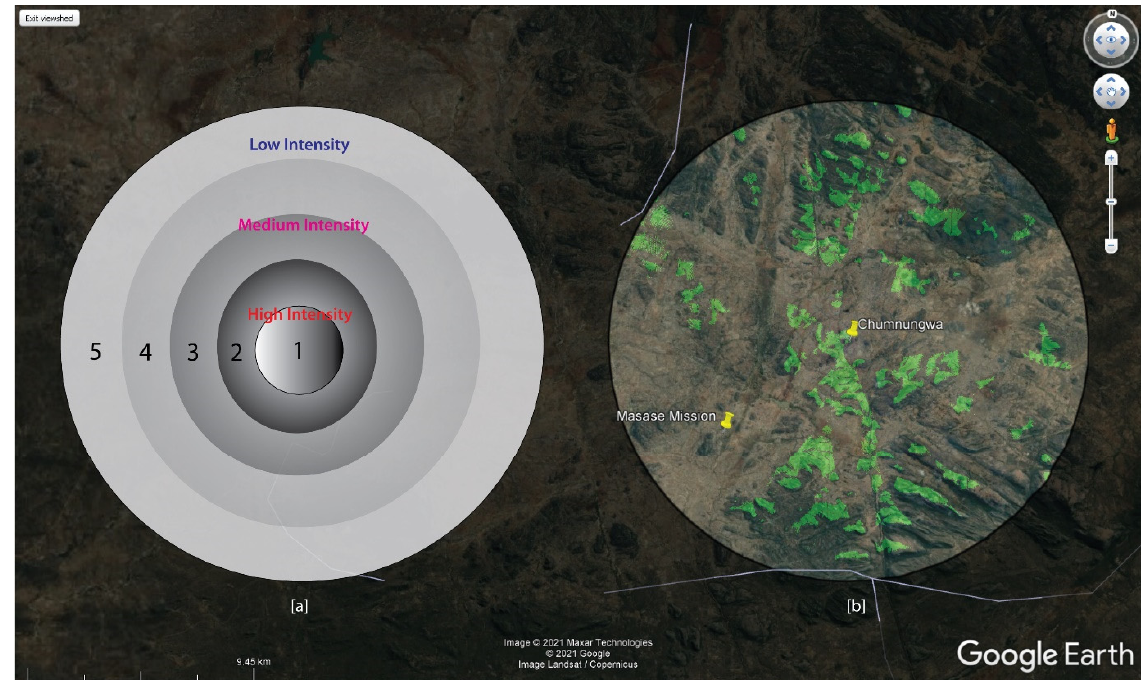
Figure 8. ( a ) Mixed land use categories within a 30 ‐ km radius modelled at the Zimbabwe sites in Mberengwa using a combination of archaeological, anthropological, and historical datasets (see Ap ‐ pendix A) (after [8,9]). ( b ) Catchment area (green sheds) of Chumnungwa within a 10 ‐ km radius (modelled using Google Earth Pro Viewshed 360 ‐ degree